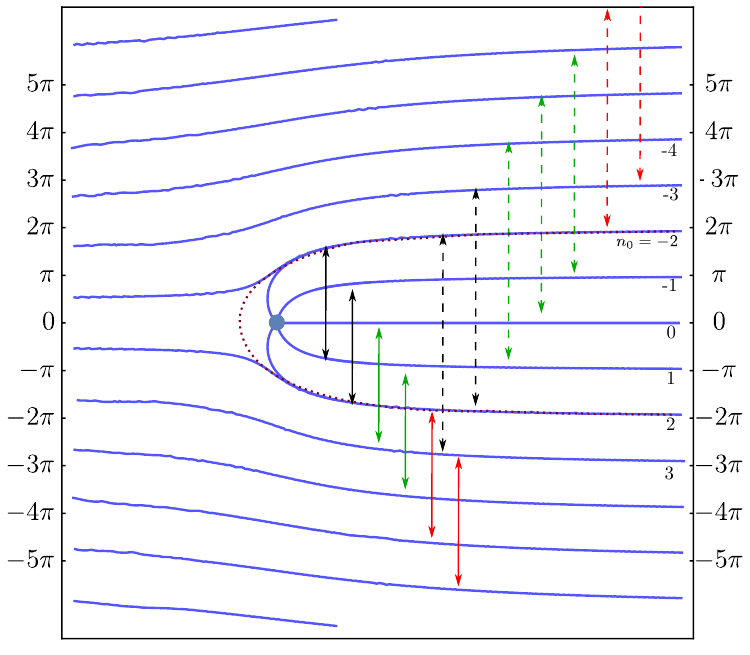
Figure 2 . Blue curves are the Stokes diagram for k = 3 and ϑ = 0 . There are five special WKB lines connected to the zero of order k = 3 . The rest of the special WKB lines connect to the negative infinity. Double headed arrows indicate which two solutions are used in the Wronskian i ( ψ ) n 1 , ψ n 2 with n = n = 2 j + 1 in different scenarios. The lower (upper) end points to the special WKB 2 − n 1 lines associated to the small solution ψ ( ψ ). Solid lines ( j = 1 ) depict scenarios 0 ≤ j ≤ k . n 2 n 1 2 Colors (black, green and red) of the lines indicate three scenarios as we shift Im θ : physical strip ( L j flows to L ), sequence of transitions ( L flows to L IR , s = 2 j − 1 , . . . , 1 ) and L IR . Dashed ⊗ L s j j j j − s 2 2 lines ( j = 2 ) depict scenarios j > k respectively. Colors (black, green and red) of the lines indicate 2 three scenarios as we shift Im θ : physical strip ( L flows to L ), sequence of transitions ⊗ L IR j k/ 2 j − k/ 2 ( L flows to L IR , s = k − 1 , . . . , 1 ) and L IR . The dotted burgundy line denotes the unique ⊗ L s j j j − s 2 2 generic WKB line that gives rise to the local integrals of